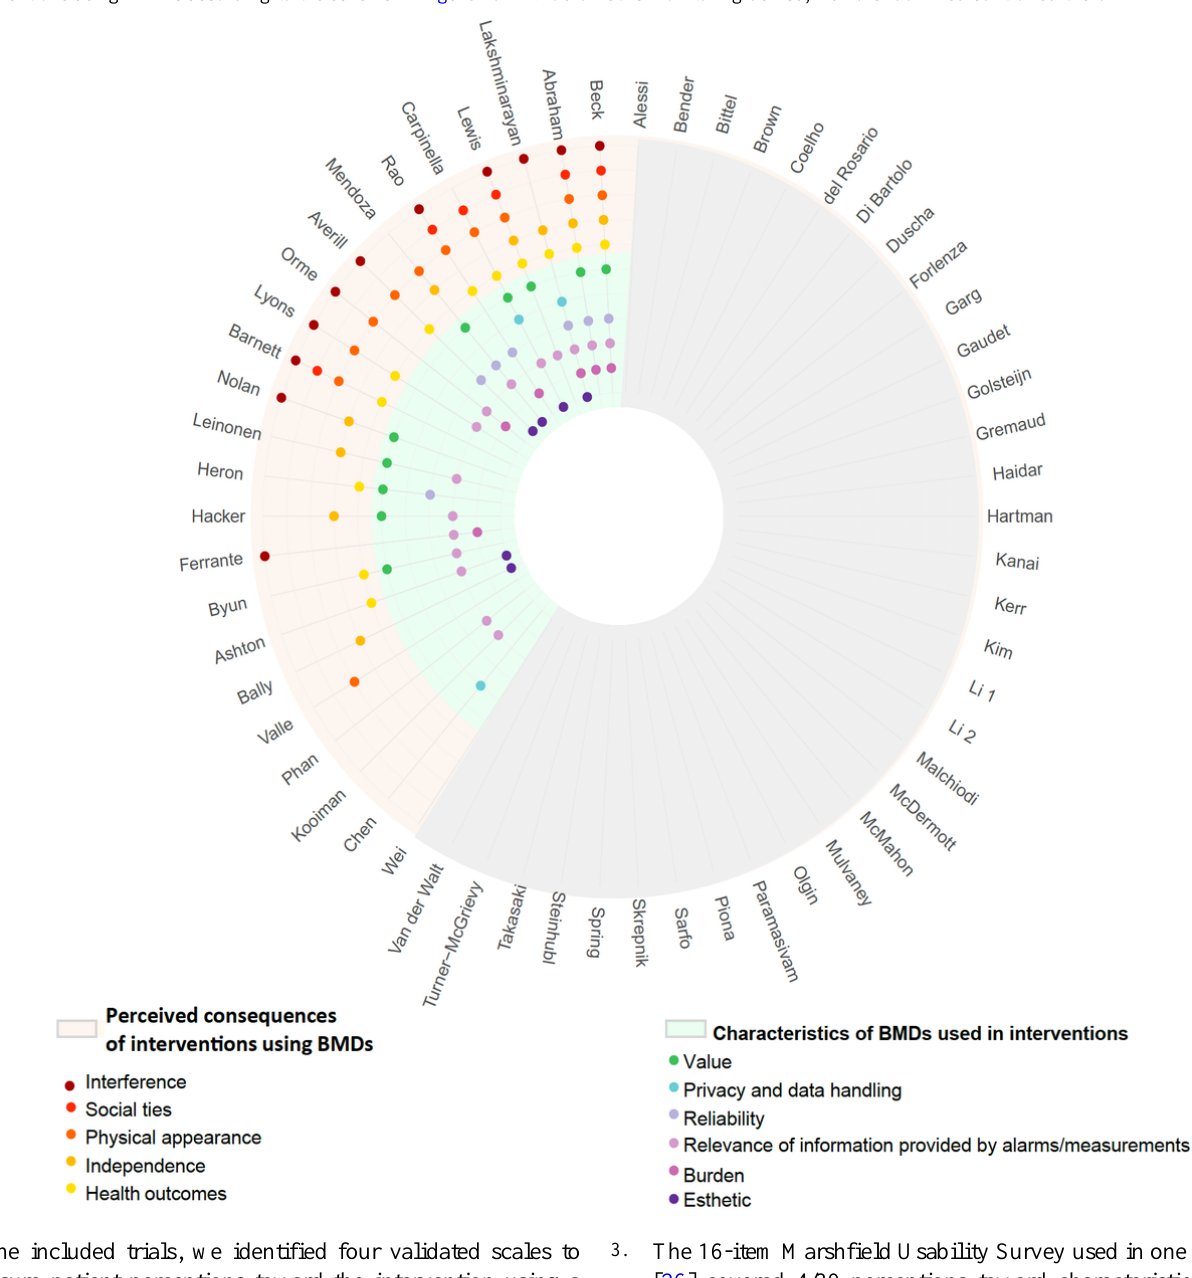
Figure 3. Patients’ perceptions toward interventions using BMDs collected in the included trials (n=58). All RCTs included in the current systematic review are shown around the figure by the first author’s last name. RCTs that collected at least one specific patient perception toward BMDs are shown in light green shading (category indicating patients’ perceptions toward characteristics of BMDs used in interventions) or beige shading (category indicating patients’ perceptions of consequences of interventions using BMDs). Gray shading corresponds to RCTs not collecting a specific patient perception toward the intervention using BMDs. Colored nodes in the interior of the figure correspond to subcategories of patient perceptions